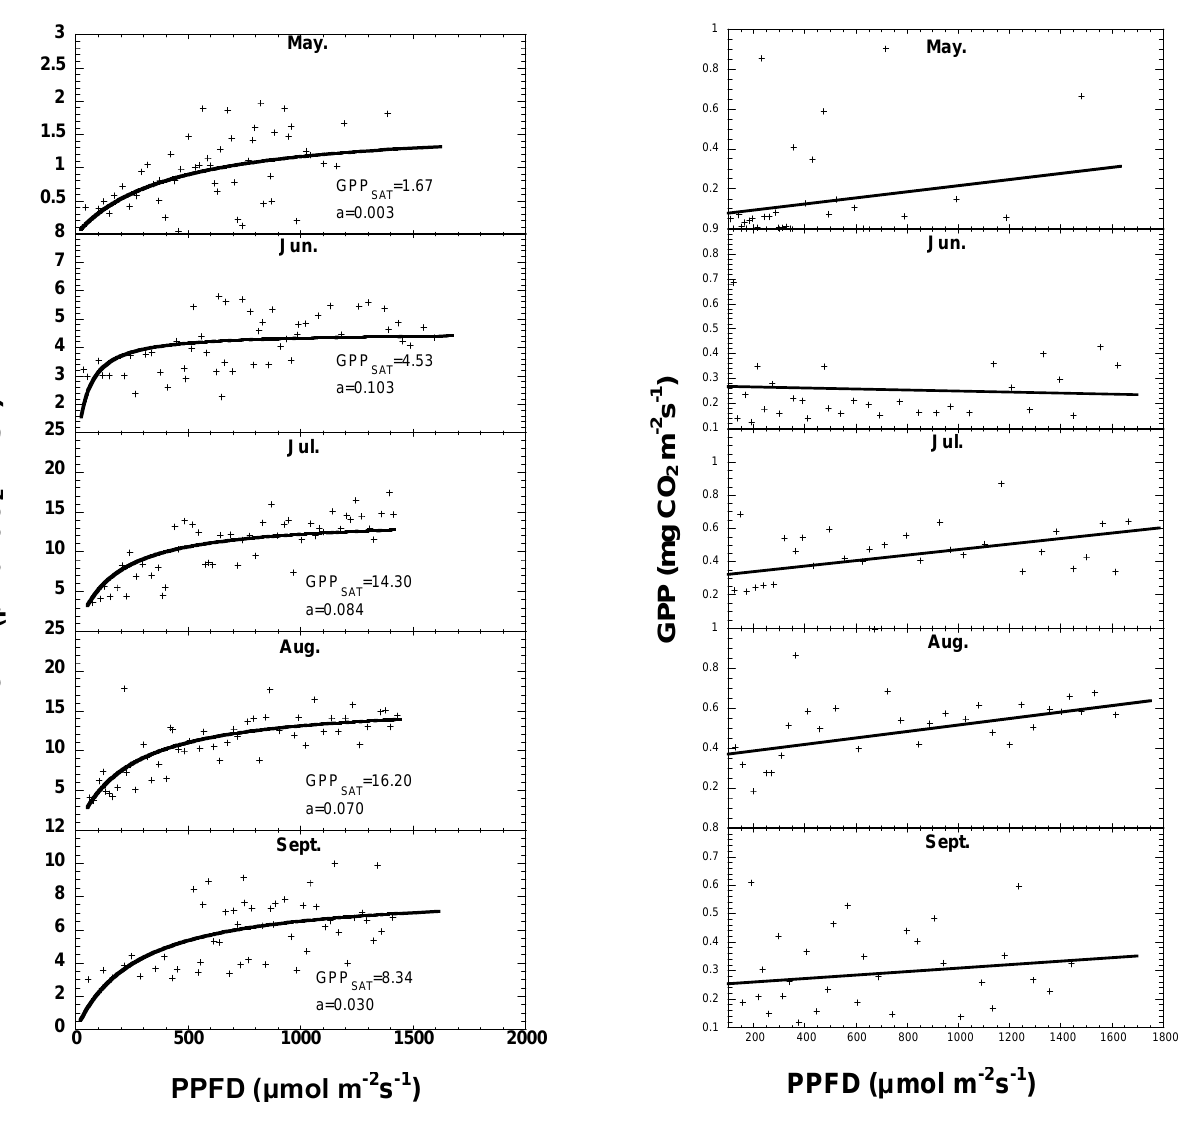
Fig.5 Linear regression of daytime gross primary production ( GPP ) on incident photosynthetic Fig. 5. Linear regression of daytime gross primary production Fig. 4. Relationship between photosynthetic photon flux density Fig. 4 Relationship between photosynthetic photon flux density ( PPFD ) and the gross primary (GPP) on incident photosynthetic photon flux density (PPFD). Data (PPFD) and the gross primary production (GPP) from May to were from 13:00–20:00 (BST).The regression follows a linear re- photon flux density ( PPFD ). Data were from 13:00-20:00 (BST).The regression follows a linear September. Fitted curves are exponentially during May to Septem- production ( GPP ) from May to September. Fitted curves are exponentially during May to lationship: GPP= b + a × PPFD. Monthly values are presented as ber. Positive values denote CO 2 assimilation by the canopy. Data follows: month ( a,r 2 ) – May (0.00015, 0.10**), June ( − 0.00002, were from 06:00–13:00 (BST). And all of the PPFD were greater relationship: GPP = b + a × PPFD . Monthly values are presented as follows: month ( a, r 2 ) － May 0.01 n.s.), July (0.00017, 0.25**), August (0.00016, 0.26**) and September. Positive values denote CO assimilation by the canopy. Data were from 6:00- than 20µmolm − 2 s − 1 . 2 September (0.00006, 0.04**). The linear relationships were signif- icant at** P < 0 . 01 level of correlation coefficients. The term n.s. (0.00015, 0.10**), June (-0.00002, 0.01 n.s.), July (0.00017, 0.25**), August (0.00016, 0.26**) 13:00(BST).And all of the PPFD were greater than 20μmolm -2 s -1 shows insignificant linear relationships. And all of the PPFD were greater than 100µmolm − 2 s − 1 and September (0.00006, 0.04**). The linear relationships were significant at** P<0.01 level of